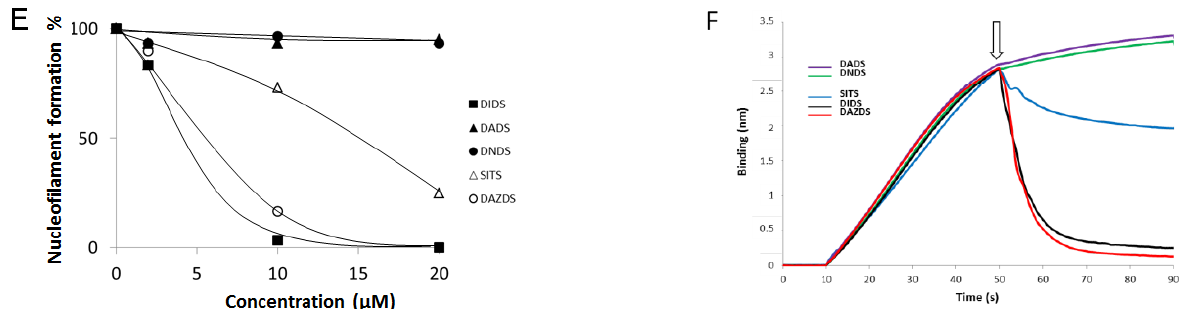
Figure 3. DIDS derivatives modulate the RAD51 nucleofilament formation. The association and dissociation between RAD51 and ssDNA were evaluated by Blitz interferometry. RAD51 (2 µM) was pre-incubated in phosphate buffer in absence or presence of each molecule at different concentrations before the measurement. The association phase followed until 50 s while the dissociation phase was monitored until 80 or 90 s, as indicated in graphs. ( A ) Effect of DIDS family on the ssDNA-RAD51 association was evaluated at 40 µM concentration of each molecule including DIDS, DADS, DAZDS, DNDS, and SITS. ( B ) DIDS, ( C ) DAZDS, and ( D ) SITS were incubated with RAD51 at increasing concentrations of 2, 10, and 20 µM for 5 min before the measurement by BLItz approach. ( E ) The percent of nucleofilament formation in presence of stilbene molecule was calculated in comparison to the condition in absence of drug after 50 s. This percentage was presented in function to the increasing concentration (from 2 to 20 µM) of each small molecule. ( F ) RAD51 associates with ssDNA until 50 s, and then each molecule is added at 40 µM as indicated by the narrow in the graph.